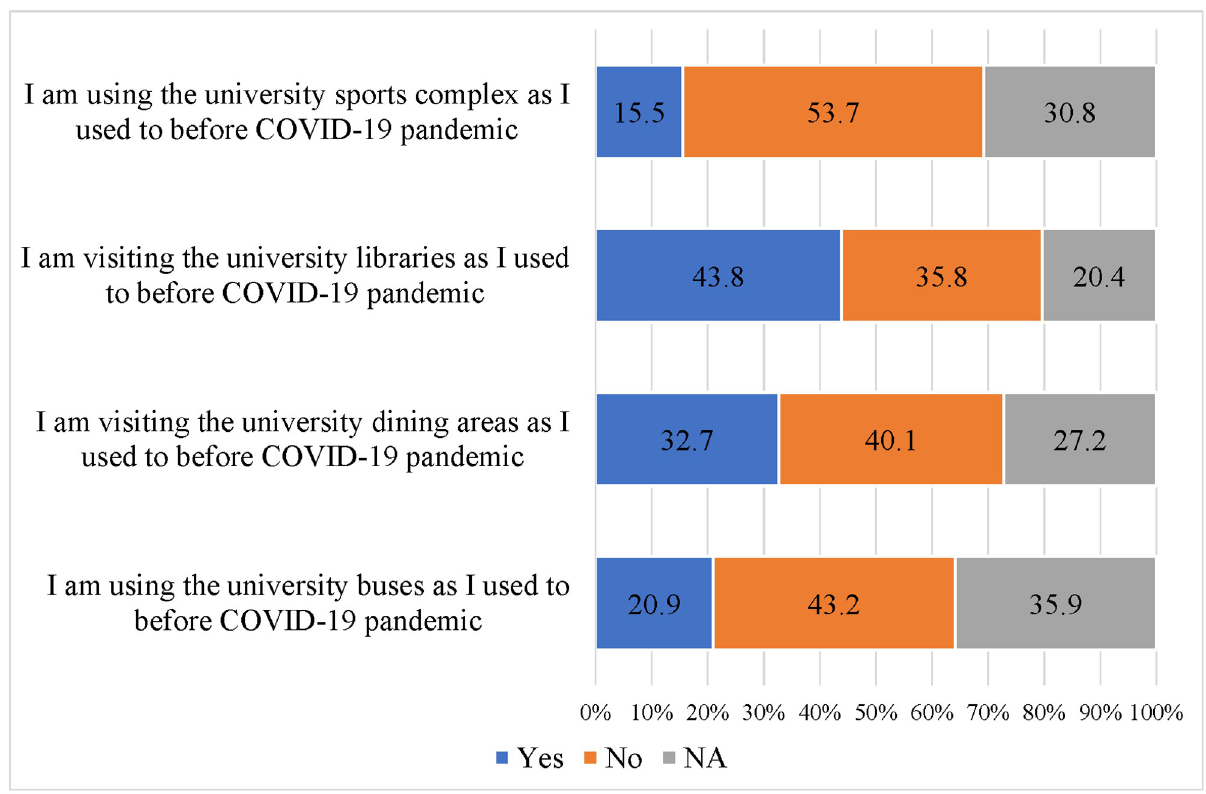
Fig 1. Changes in university life during hybrid learning.